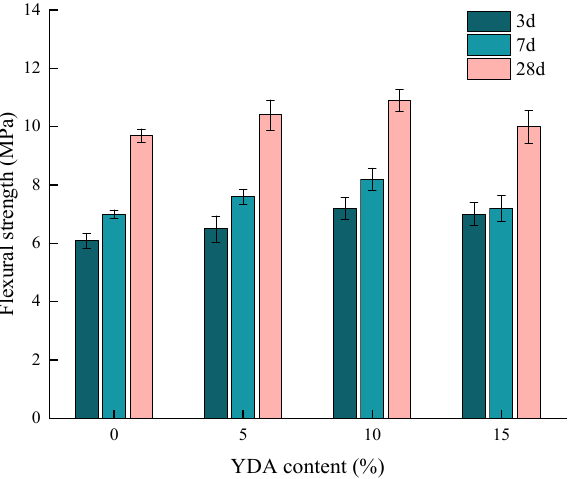
Figure 11. Effects of YDA content on the flexural strength of cementitious mortars.